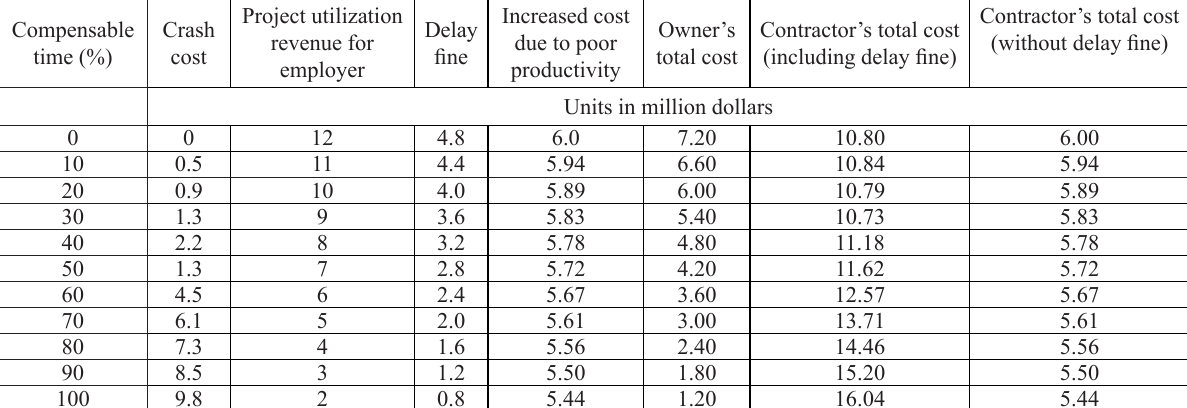
Table 1. Overall payoff for owner and contractor against the compensable time